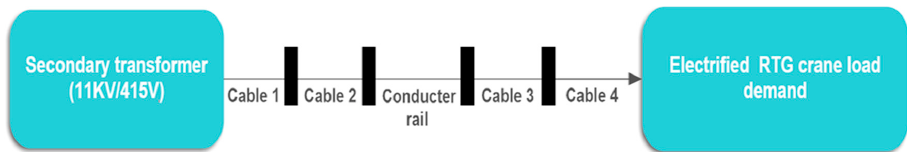
Figure 7. The schematic of an electrified RTG crane network system.